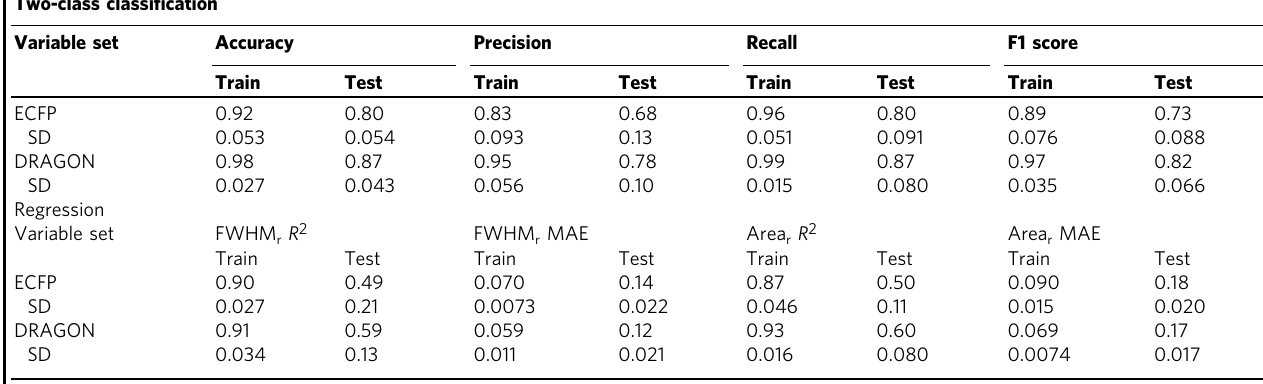
Top: Two-class classi fi cation (appropriate solvent prediction) based on ECFP or DRAGON. Bottom: Regression of FWHM r and Area r from ECFP or DRAGON. The performance metrics for classi fi cation (Accuracy, Precision, Recall, and F1 score) and those for regression (coef fi cient of determination R 2 and mean absolute error (MAE)) are calculated by Scikit-learn 76 . The fi rst value in each cell displays the mean, and the second value displays the standard deviation